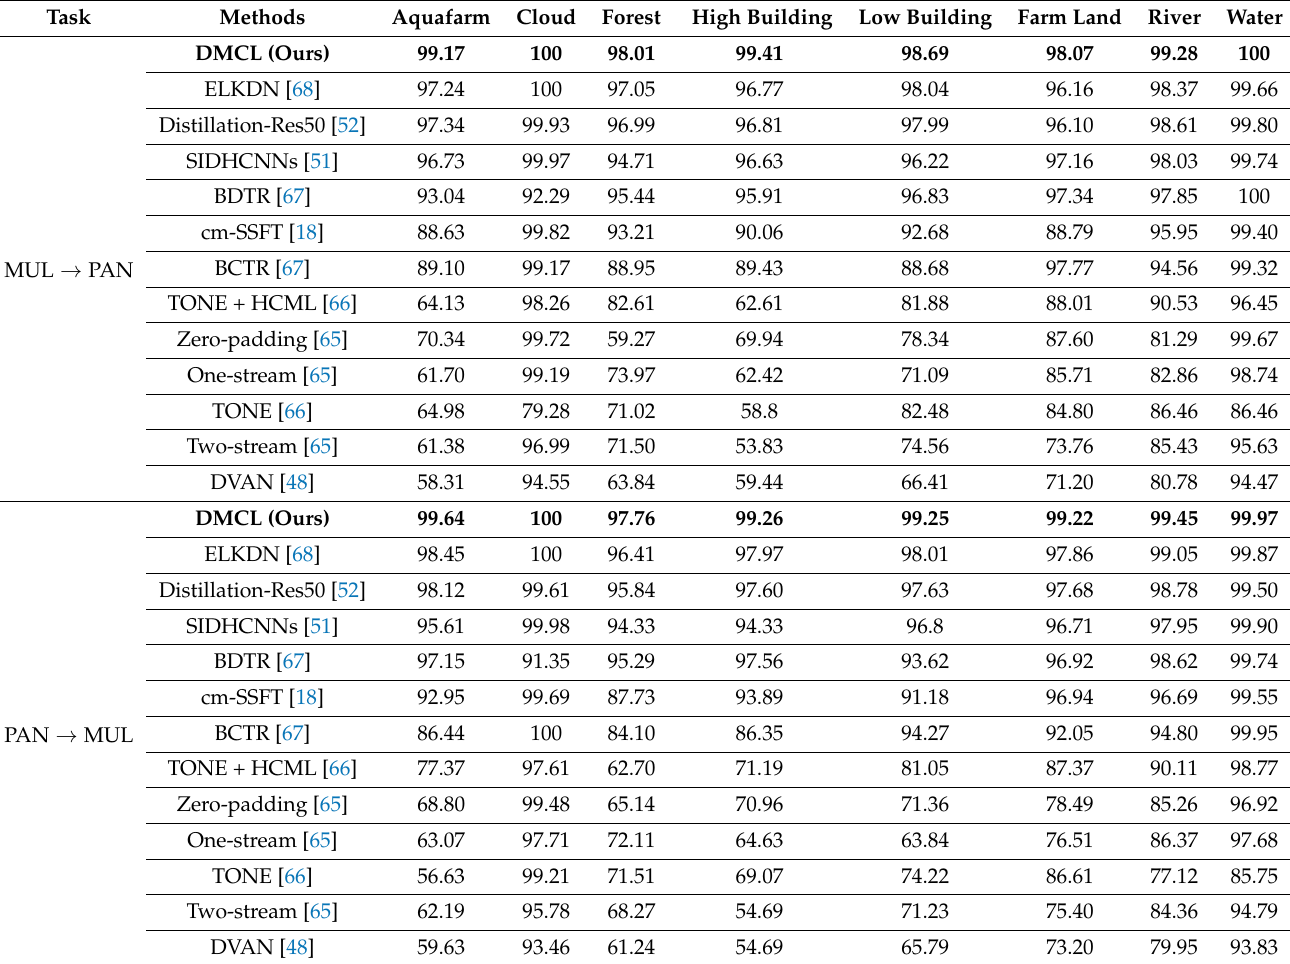
Table 3. MAP values (%) of different models measured in the DSRSID. MUL → PAN means the query is MSP images, and the target samples are PAN images. PAN → MUL indicates the query is PAN images, and the target samples are MSP